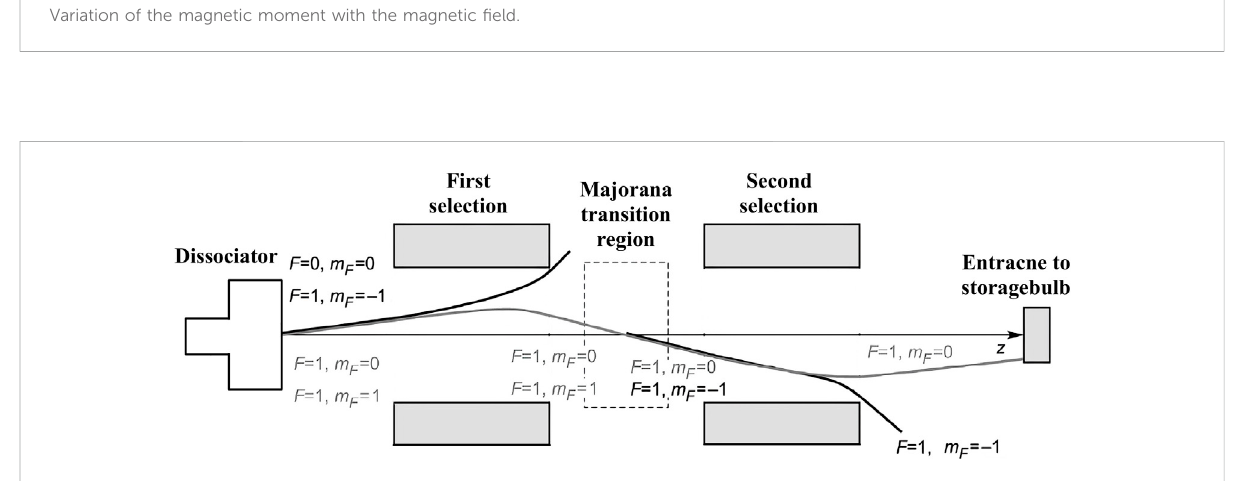
FIGURE 7 Schematic diagram of a single-state ( F (cid:1) 1 , m F (cid:1) 0 ) selector for the H-maser.